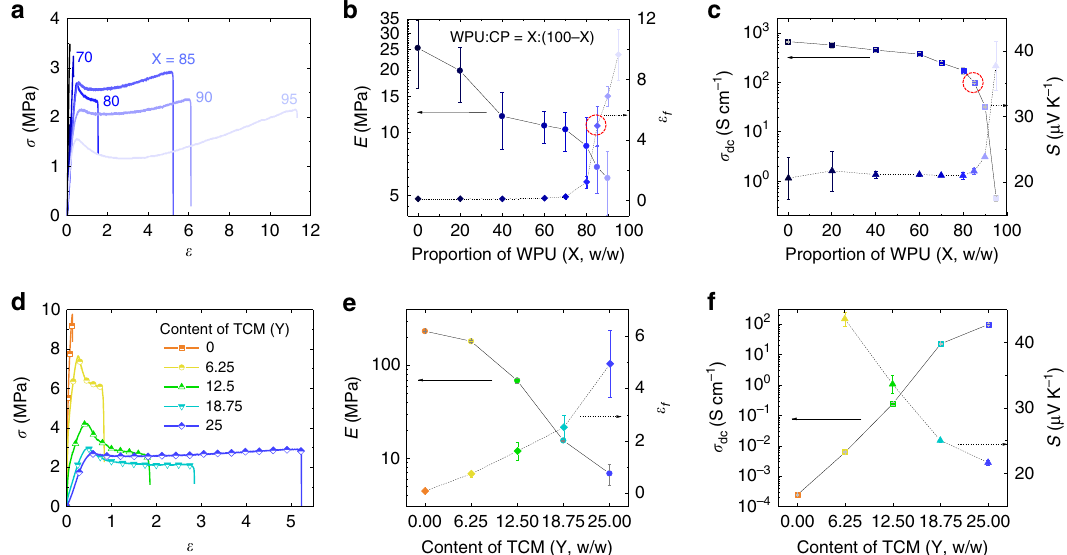
Fig. 2 Mechanical, electrical, and thermoelectric properties. a Stress ( σ )-strain ( ε ) curve, b Young ’ s modulus ( E ) and fracture strain ( ε f ), c electrical dc conductivity ( σ dc ) and Seebeck coef fi cient ( S ) of the composite with varying proportion of WPU (X) to CP (100 − X). The composition ratio of the chosen IL (TCM) to CP was fi xed at CP:TCM = 15:25. There is a drastic change in all properties in the range X = 80 − 95. The red dotted circles indicate the data points at the optimized X ( ≈ 85). d σ - ε curve, e E and ε f , f σ dc and S of the composite with varying content of TCM (Y). The proportion of WPU to CP was fi xed at CP:WPU = 15:85. Composition ratio, CP:TCM:WPU = 15:Y:85. w/w for all composition ratios. Error bars represent the standard deviation (SD).